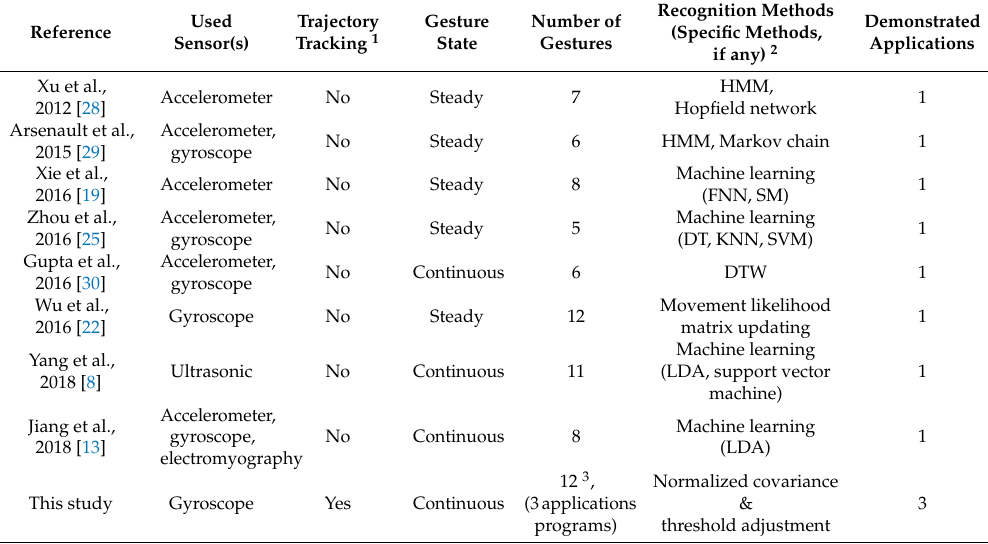
Table 1. Summary of related works regarding wearable sensor-based gesture